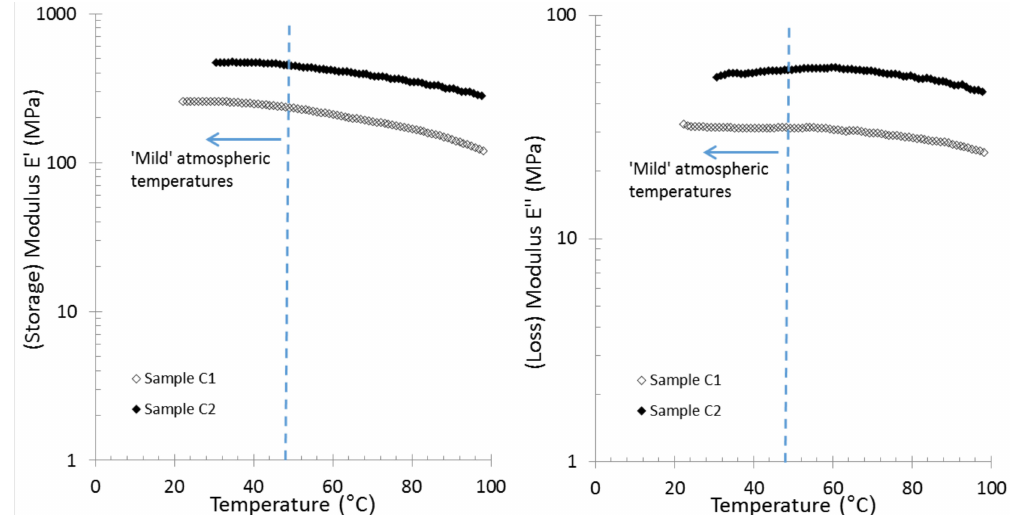
Figure 6. DMTA analysis of the polymer at two locations, C1 and C2, giving measurements of (left) the storage modulus and (right) loss modulus (this